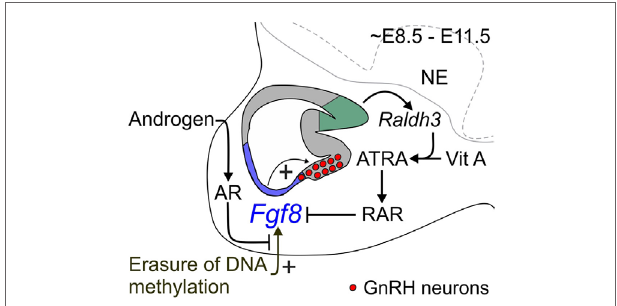
FiGURe 1 | Proposed mechanism for coordinate regulation of transient Fgf8 transcription in the mouse OP . Sagittal schematic representation of the ~E8.5–E11.5 mouse nasal region. FGF8 expressing cells located in the respiratory epithelium (blue region) are required for GnRH neuron emergence in the embryonic mouse mOP (red circles) located in the olfactory epithelium (gray region). Evidence from our and other studies indicates three major signaling mechanisms that regulate transient Fgf8 expression in the embryonic mouse OP. First, our data showed that AR directly interacts with its ARE sites on the Fgf8 promoter region. However, in contrast to our premise, DHT did not upregulate Fgf8 expression in GT1–7 neurons or the embryonic OP. Second, inhibition of DNMT activity upregulated Fgf8 expression suggesting that the erasure of DNA methylation induced Fgf8 promoter activity. Surprisingly, DHT was able to block this effect, which led us to infer that androgen signaling-dependent modulation of Fgf8 transcription in the embryonic OP is reliant on the epigenetic status of the Fgf8 promoter. Third, ATRA signaling clearly inhibits Fgf8 expression. The embryonic OP exhibits an age-dependent increase in ATRA levels due to the local upregulation of Raldh3 expression [converts vitamin (Vit) A to ATRA] in the dorsal–caudal region olfactory epithelium (green region), which then acts through RARs to inhibit Fgf8 expression. These data led us to update our hypothesis as to how transient Fgf8 transcription is controlled in the embryonic mouse OP: upregulation of Fgf8 transcriptional activity is DNA methylation-dependent, which is subsequently downregulated through androgen and/or ATRA signaling. In this context, androgen and/or ATRA signaling may act as a transcriptional brake to limit FGF8’s morphogenetic or proliferative effects on the embryonic mouse OP. NE,